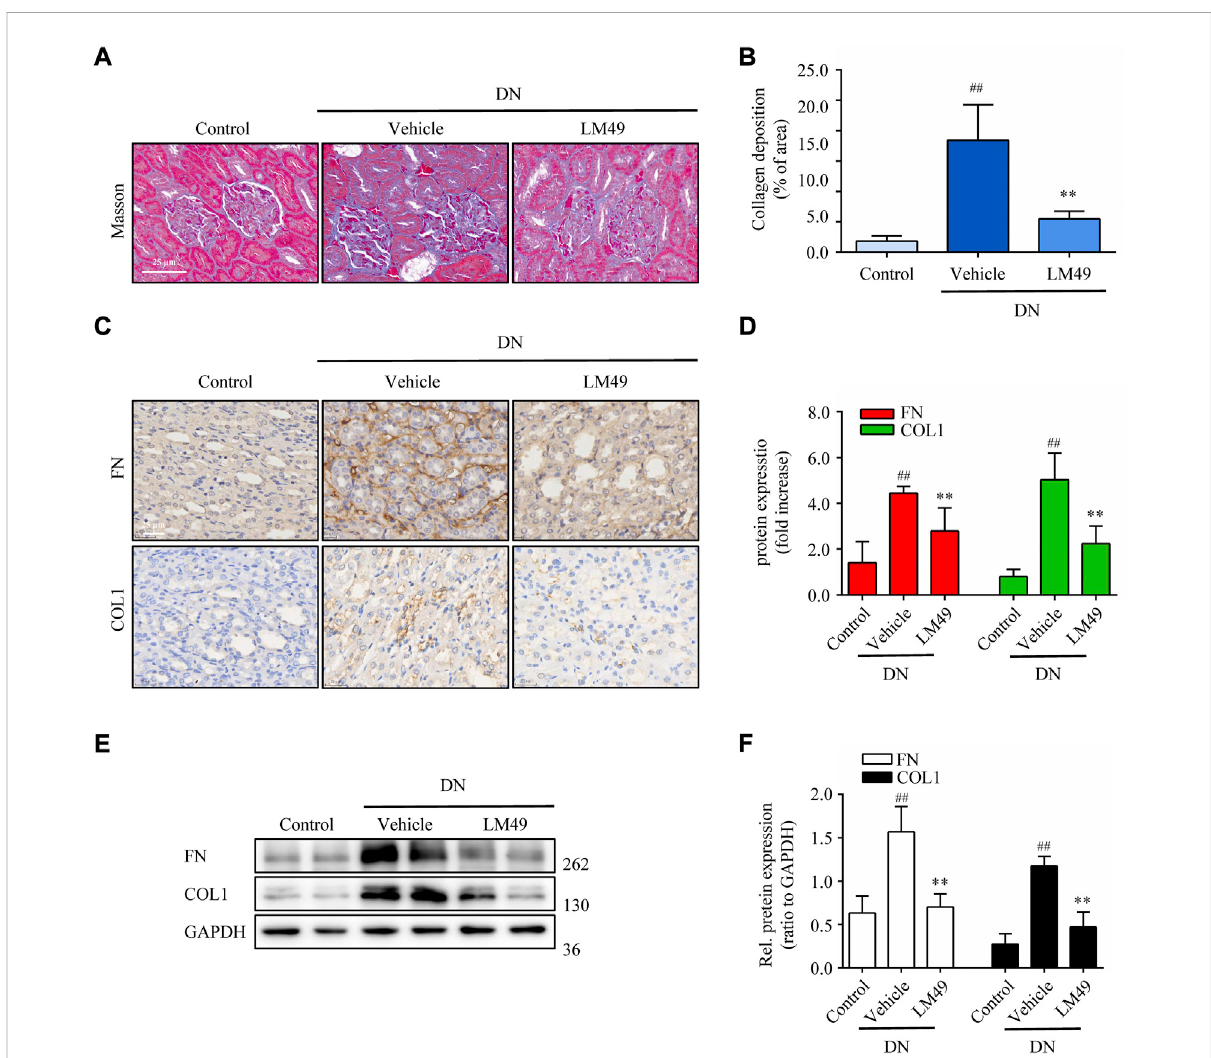
FIGURE 1 LM49attenuatesrenal fi brosisinDNrats. (A) RepresentativemicrographsofMasson ’ strichromestaininginindicatedgroups.(Scalebar,25 μ m). (B) Quanti fi cation of collagen deposition in kidney tissue. ## p < 0.01 compared with control group, ** p < 0.01 compared with vehicle group (n = 3). (C) Representativemicrographsofimmunohistochemicalstaining(IHC)forFNandCOL1inindicatedgroups.(Scalebar,25 μ m) (D) Quanti fi cationof IHC staining of (C) , ## p < 0.01 compared with control group, ** p < 0.01 compared with vehicle group (n = 3). (E) Immunoblot analysis of the protein expression of FN and COL1 of kidney tissues separated from indicated groups. (F) Quanti fi cation of FN and COL1 intensity in (E) . ## p < 0.01 compared with Control group, ** p < 0.01 compared with Vehicle group (n =